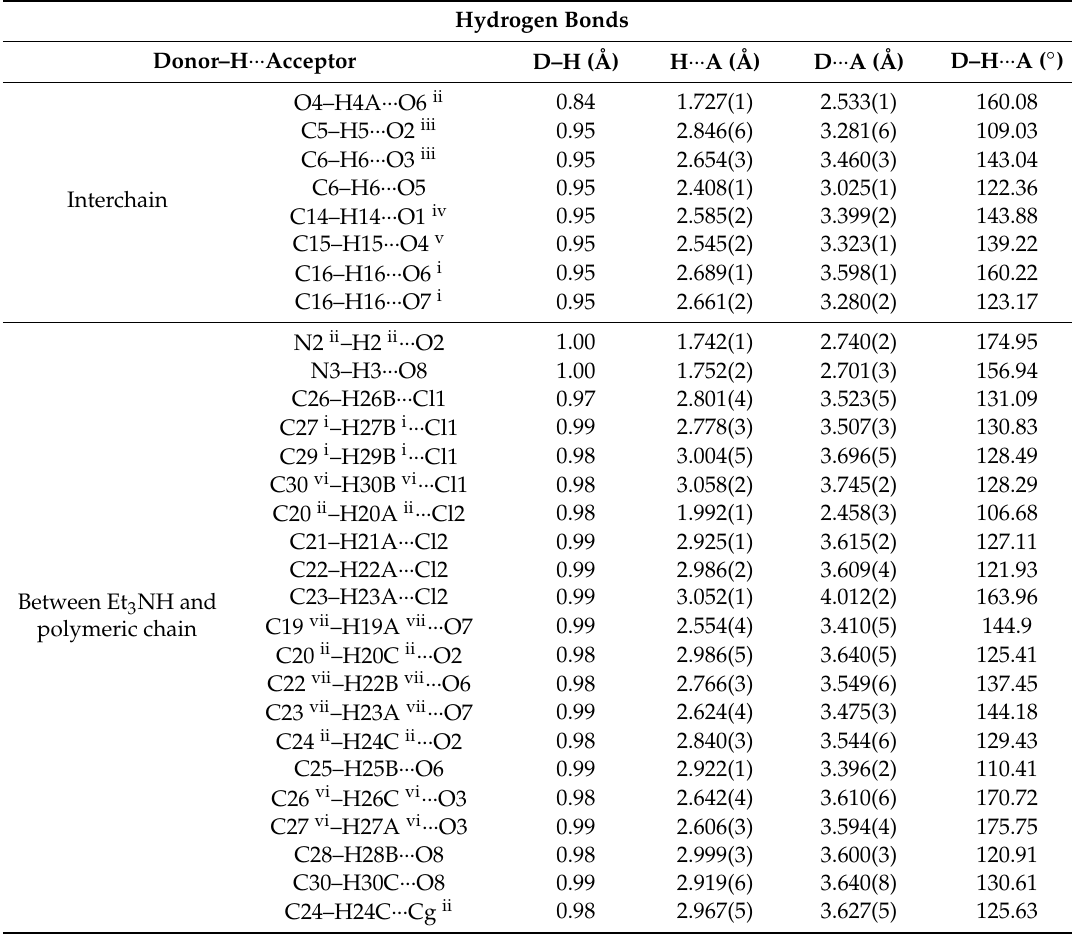
Table 4. The geometry of noncovalent interactions in complex 2 .